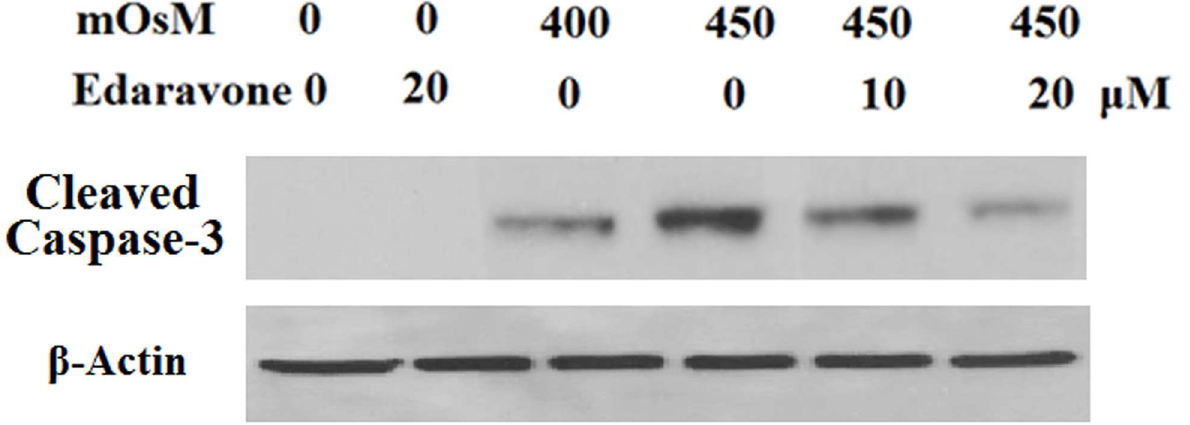
Fig 7. Effects of edaravone on cleaved caspase-3 as measuredby western blot analysis. Edaravonetreatment inhibitsthe increase in cleavedcaspase-3inducedby hyperosmotic exposure (400–450 mOsM) (ANOVA: * , P < 0.001vs. non-treatmentcontrol; #, P < 0.001 vs. 450 mOsM treated